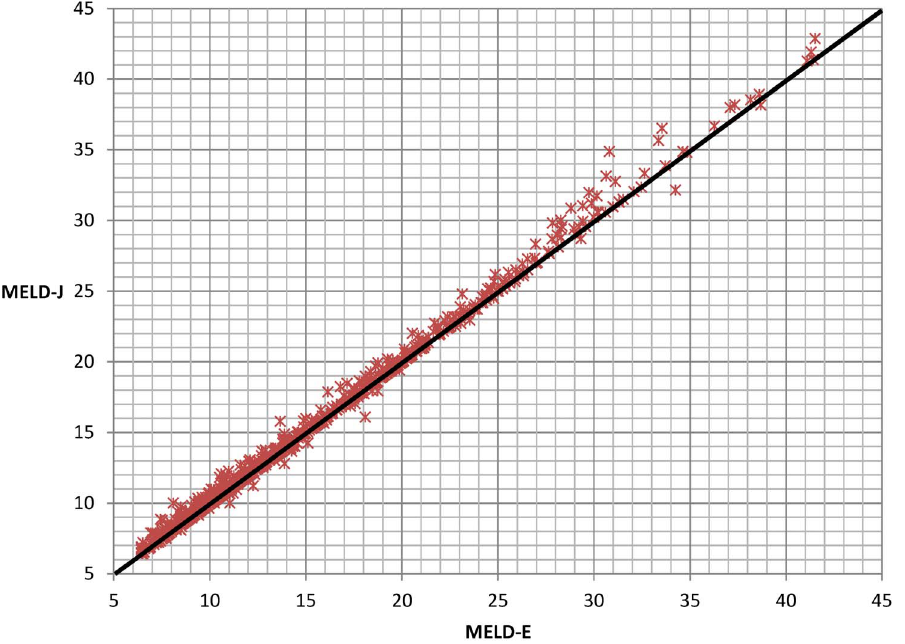
Figure 2. Correlation between MELD-J and MELD-E results. For this figure, we did not restrict the MELD scores to a maximum of 40 points, and values were not rounded (r=0.998; p , 0.001).